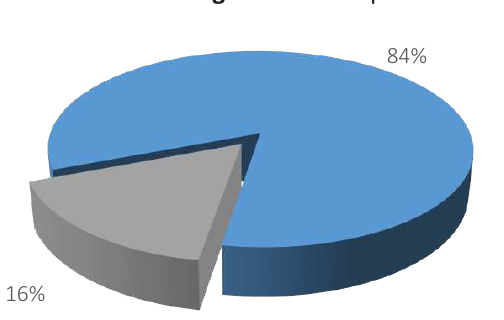
Figure 5. Travel preferences